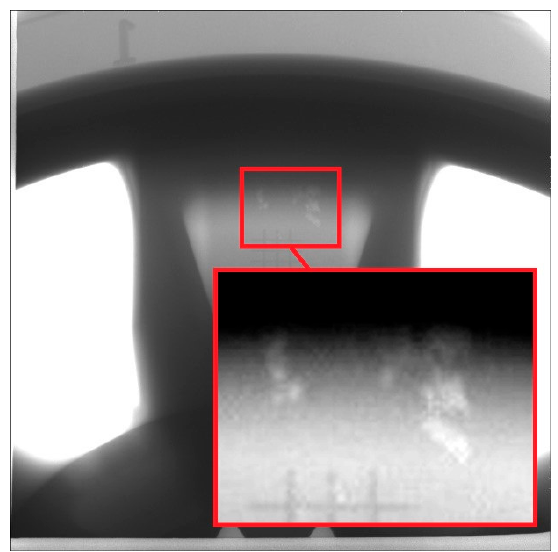
Figure 19. Large size shrinkage-based porosity found at the rim/spoke conjunction.